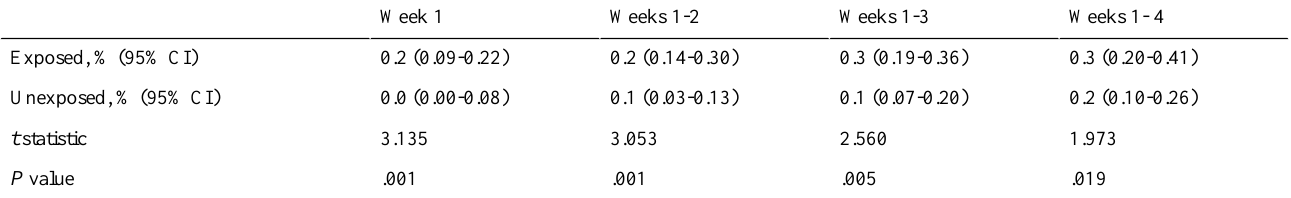
Table 4. Visits to other cessation sites (national, state,